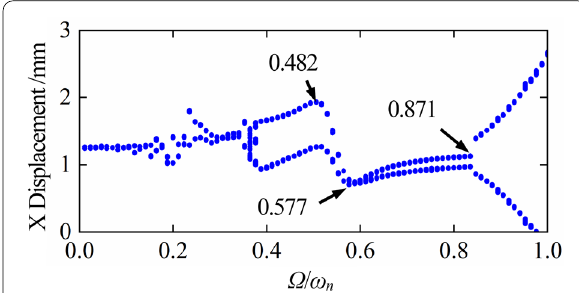
Figure 11 Diagrammatic sketch of bifurcation about the ratio of rotational speed to first-order critical speed